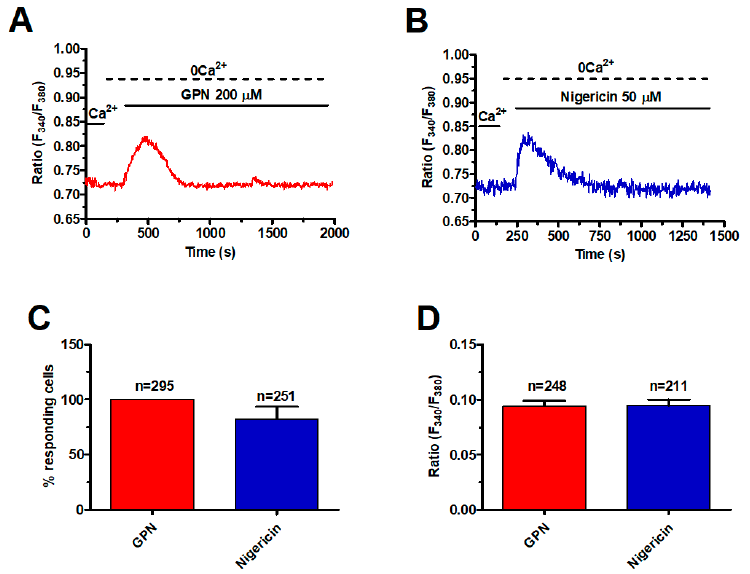
Figure 1. A functional lysosomal Ca 2+ store is present in metastatic colorectal cancer (mCRC) cells. ( A ) the lysosomotropic compound, glycyl-l-phenylalanine-2-naphthylamide (GPN) (200 µ M), caused a robust increase in [Ca 2 + ] i in the absence of external Ca 2 + (0Ca 2 + ) in mCRC cells loaded with the Ca 2 + -sensitive fluorophore, Fura 2 / AM (4 µ M, 30 min). ( B ) nigericin (50 µ M), which dissipates the ∆ pH ( C ) mean ± SE of the percentage of responding cells to GPN and nigericin, respectively. ( D ) mean ±